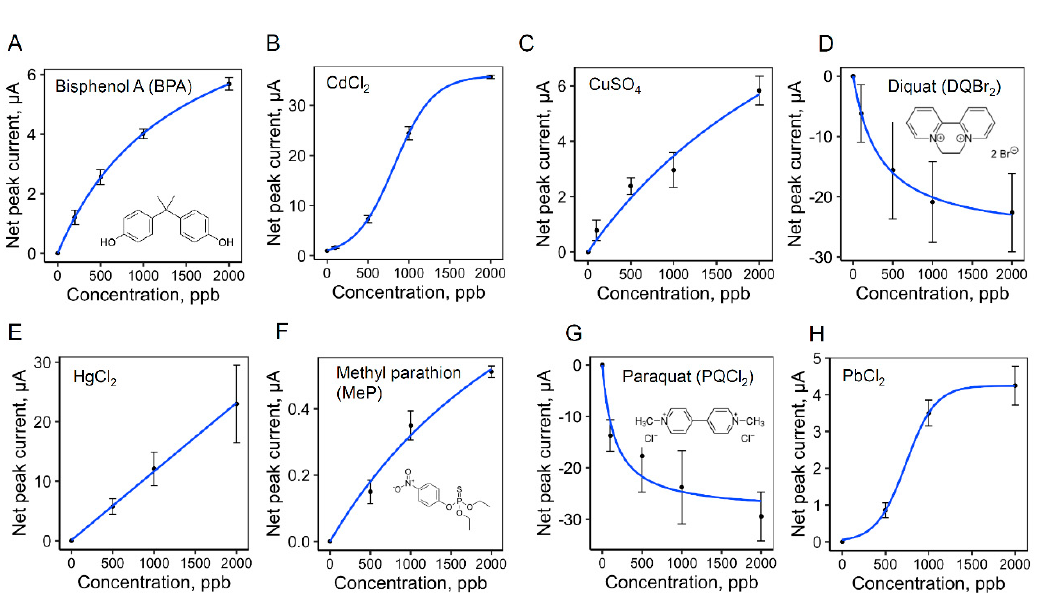
Figure 4. The dose response of seawater spiked with environmental contaminants. The peaks from the cyclic square wave voltammetry and fitting parameters used for the analysis are listed in Table 1.